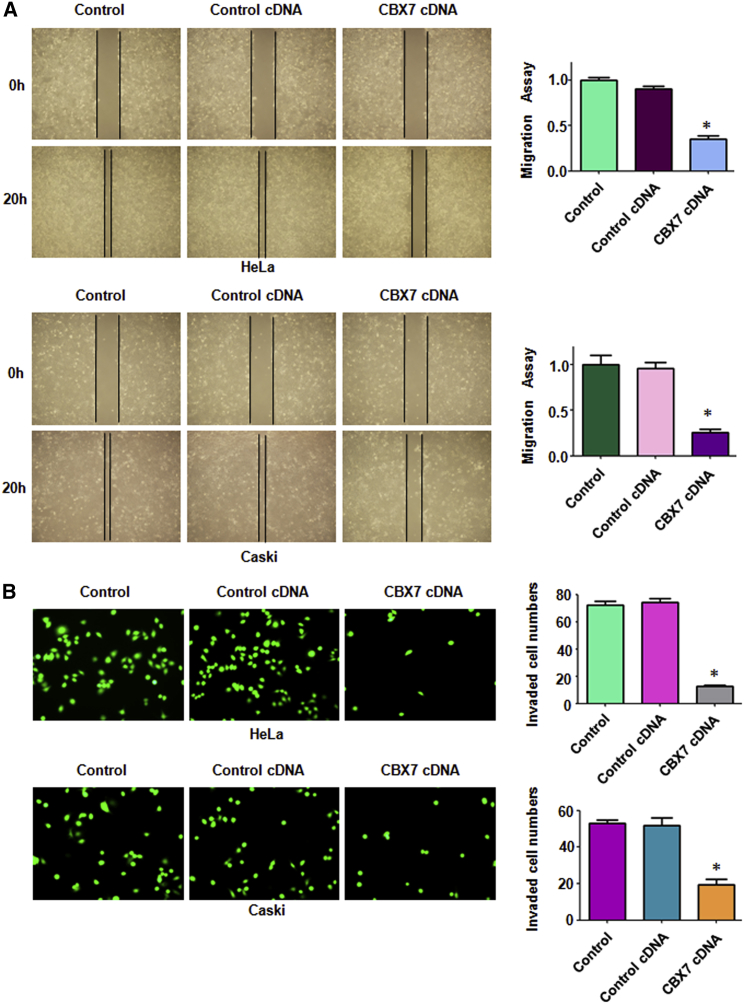
Overexpression of CBX7 Inhibits Cell Migration and Invasion(A) Left: the ability of cell migration was determined via a wound-healing assay in cervical cancer cells after CBX7 construct transfection. Right: Quantitative results are illustrated for left. *p < 0.05 versus control group. (B) Left: the ability of cell invasion was measured via the Transwell assay in cervical cancer cells after CBX7 construct transfection. Right: quantitative results are illustrated for left. *p < 0.05 versus control group.